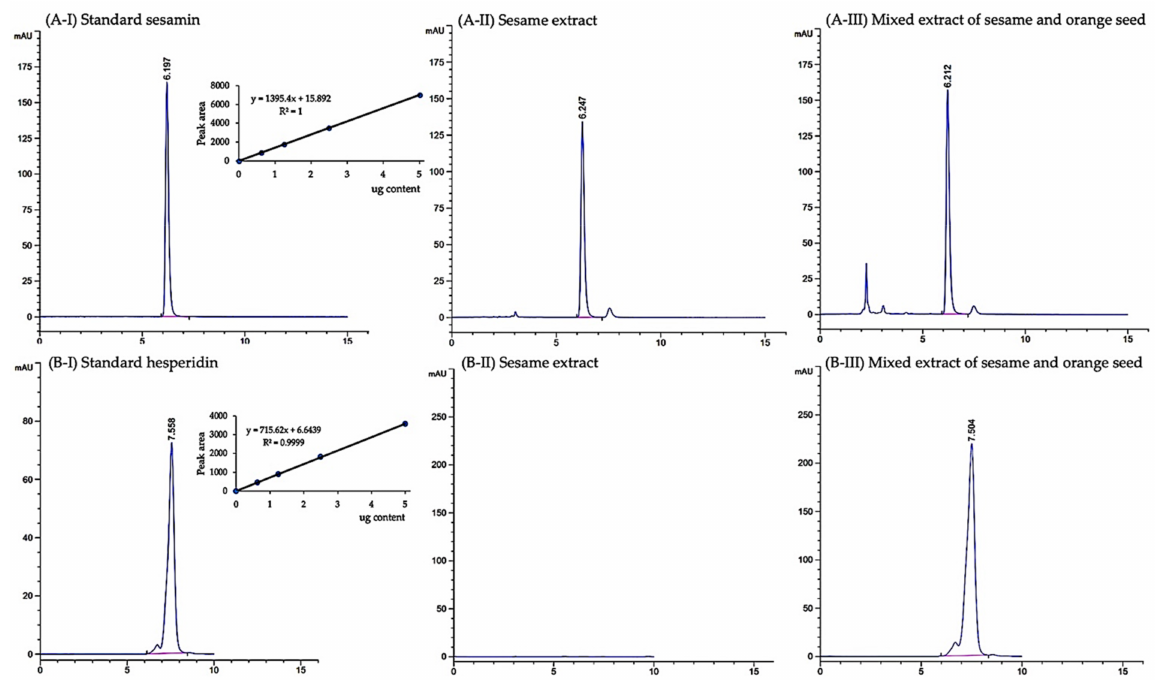
Figure 2. Chromatogram of sesamin ( A ) and hesperidin ( B ) in sesame extract and mixed extract of sesame and orange seed using HPLC.